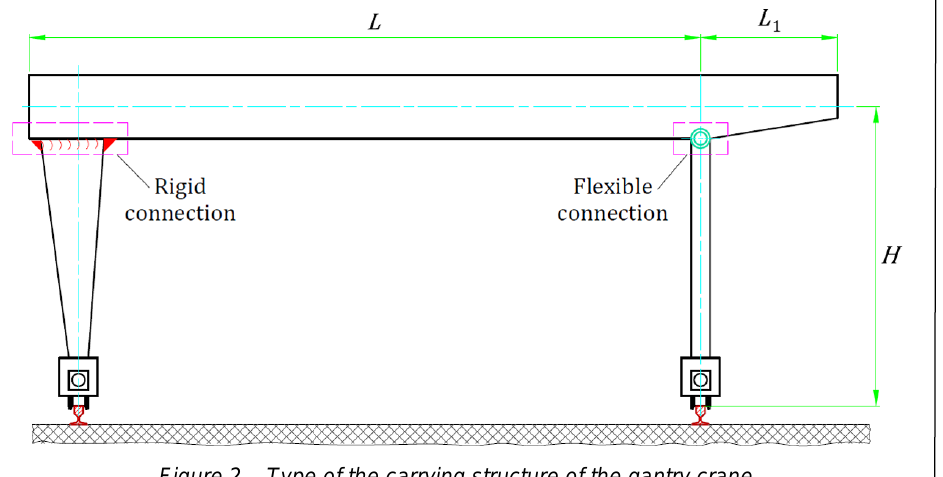
Figure 2 – Type of the carrying structure of the gantry crane Рис. 2 – Тип несущей конструкции козлового крана Слика 2 – Тип носеће конструкције рамне